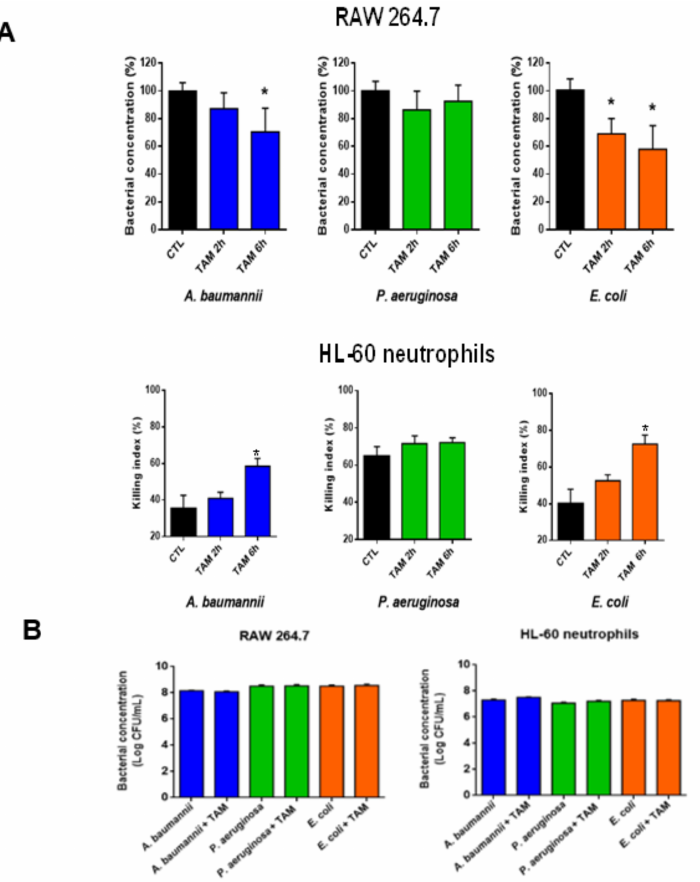
Figure 6. Tamoxifen induces the phagocytic activity of macrophages and neutrophils. RAW 264.7 cells and HL-60 neurophils were incubated with tamoxifen for 2 or 6 h and infected for 2 h with A. baumannii ATCC17978, P. aeruginosa PAO1, or E. coli ATCC25922 strains (MOI:100) ( A ) The adherence and invasion of these strains are expressed as the percentage of total control strain adhered or internalized to RAW 264.7 and the killing index of HL-60 neutrophil cells is expressed as the percentage. ( B ) The extracellular strains in the culture medium after 6 h of tamoxifen incubation are determined as Log colony-forming units (CFU)/mL. Data are representative of three independent experiments, and expressed as mean ± SEM. * p < 0.05: treated vs. CTL. CTL: infected cells without tamoxifen